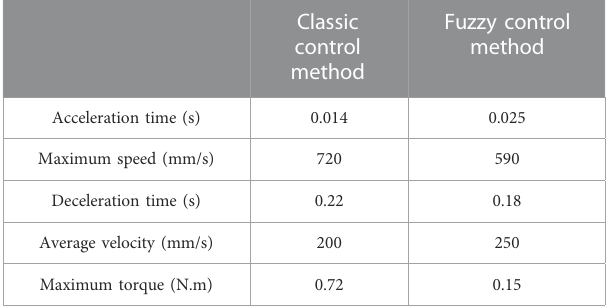
TABLE 2 Simulation comparison between classical control and fuzzy